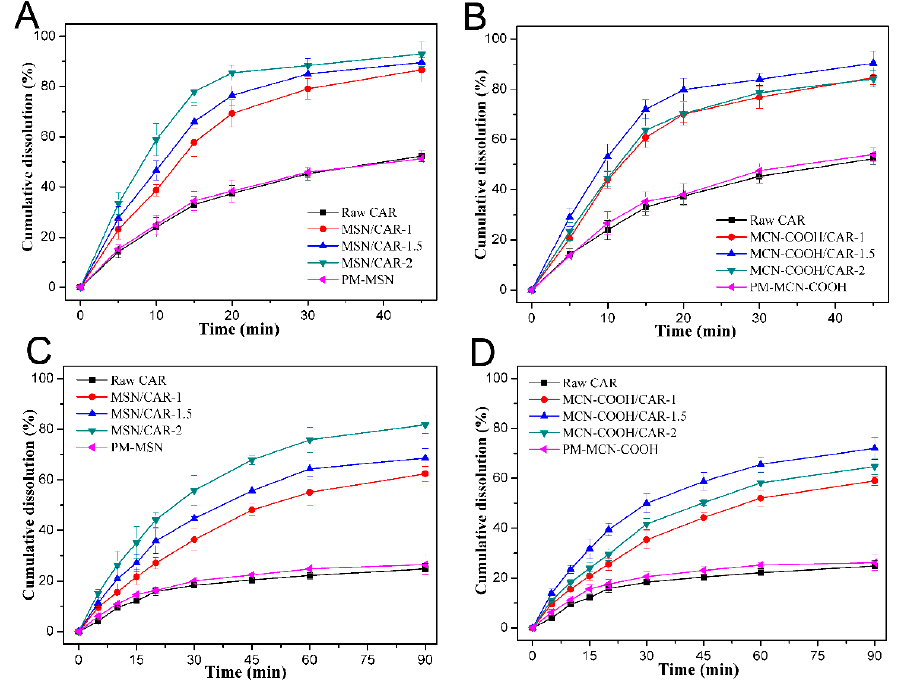
Figure 6. In vitro dissolution profiles of raw CAR, MSN / CAR–1, MCN / CAR–1.5, MCN / CAR–2 and physical mixture (PM)–MSN in ( A ) simulated gastric fluid (SGF) and ( C ) simulated intestinal fluid